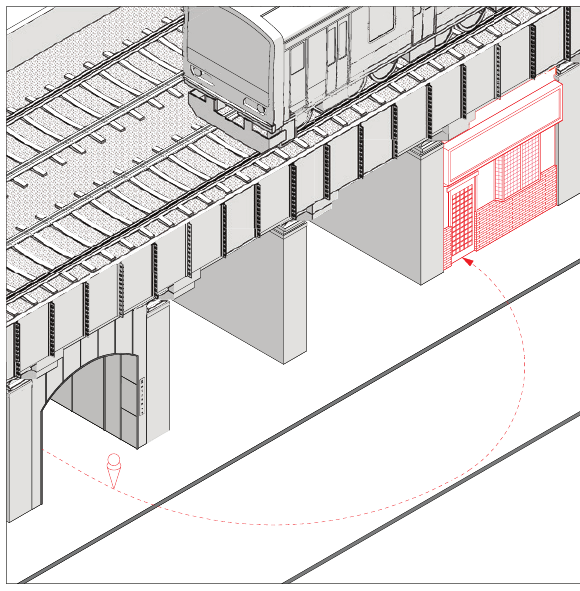
Figure 2. Relationship of host and the parasite through movement